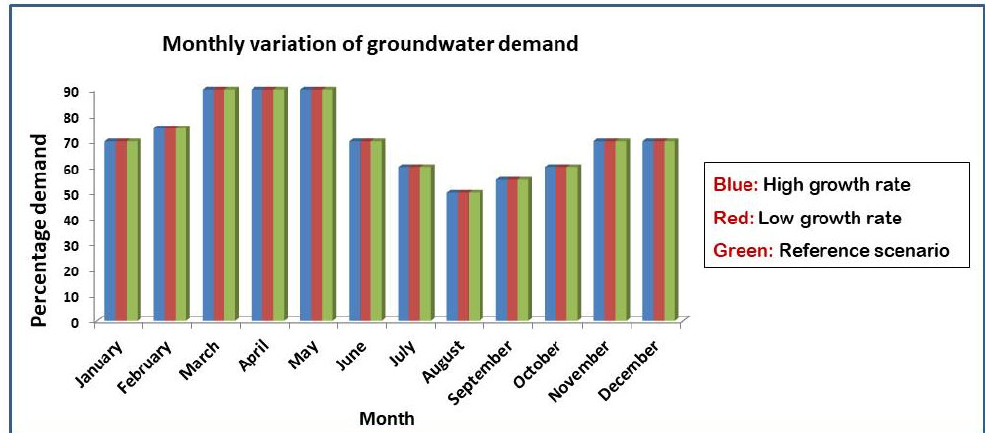
Figure 11. The monthly variation of groundwater demand in the study area.